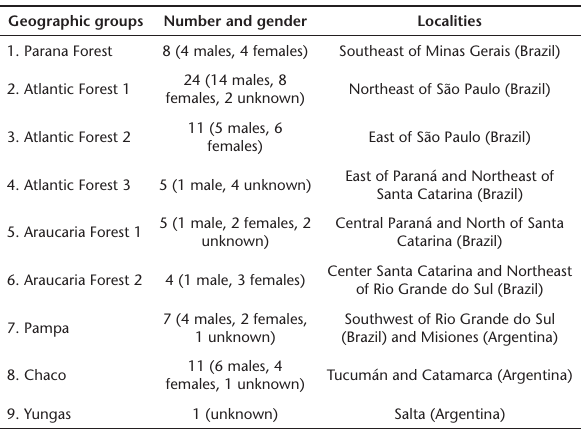
Table 1. Geographic groups and respective number of skins used for statistical analysis.